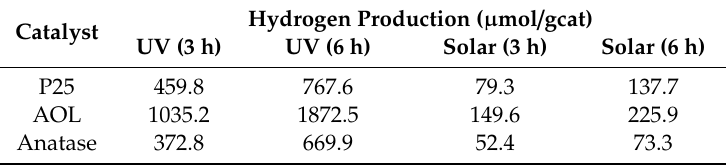
Table 2. Hydrogen photo-production on P25, AOL and anatase simples using UV or solar light.